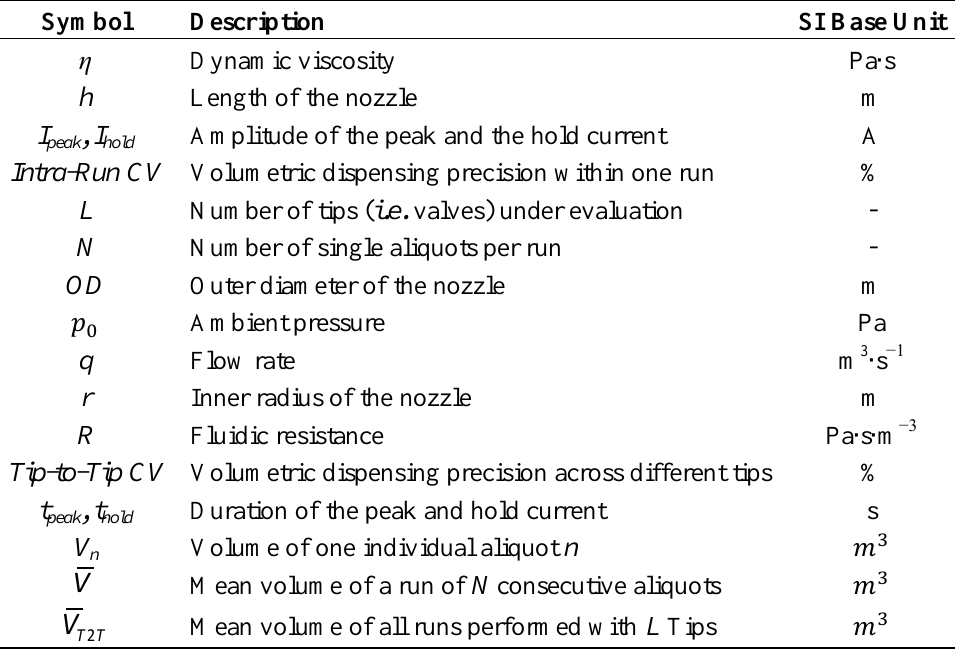
Table 1. Nomenclature of the symbols used throughout this